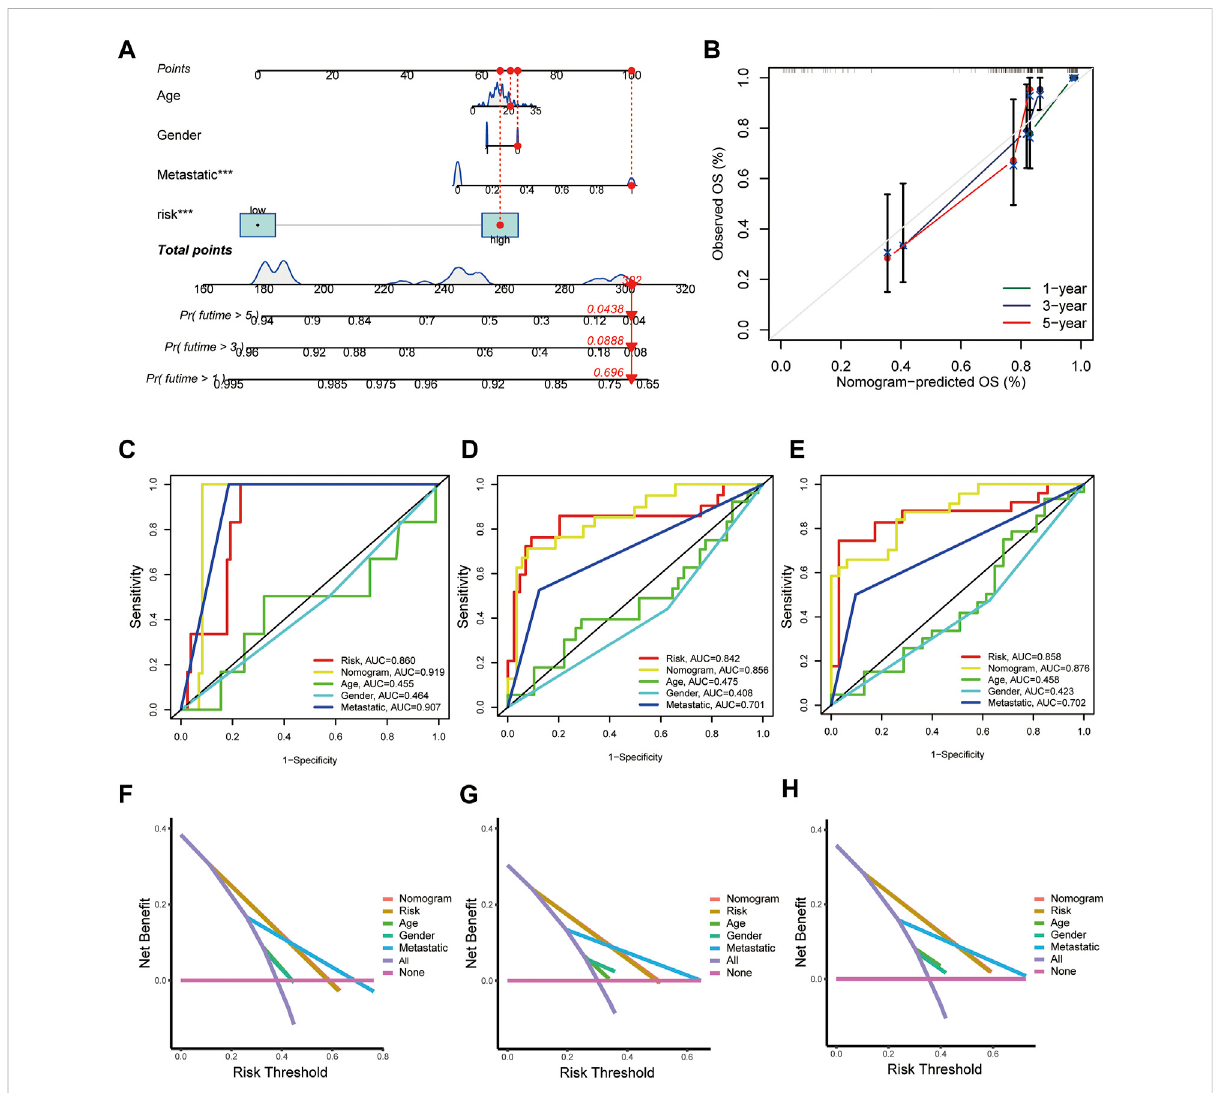
FIGURE 5 ConstructionandvalidationofanomogramforpredictingtheprognosisofOSpatients. (A) Nomogramforpredictingthe1-,3-,and5-yearsOS of osteosarcoma patients in the TARGET-OS cohort. (B) Calibration curves for validating the established nomogram. (C – E) The ROC curves of the nomogramscomparedfor1-,3-,and5-yearsOSinosteosarcomapatients, respectively. (F – H) TheDCAcurvesofthenomogramscomparedfor1-, 3-, and 5-years OS in osteosarcoma patients, respectively. ( p < 0.05 *; p < 0.01 **; p < 0.001